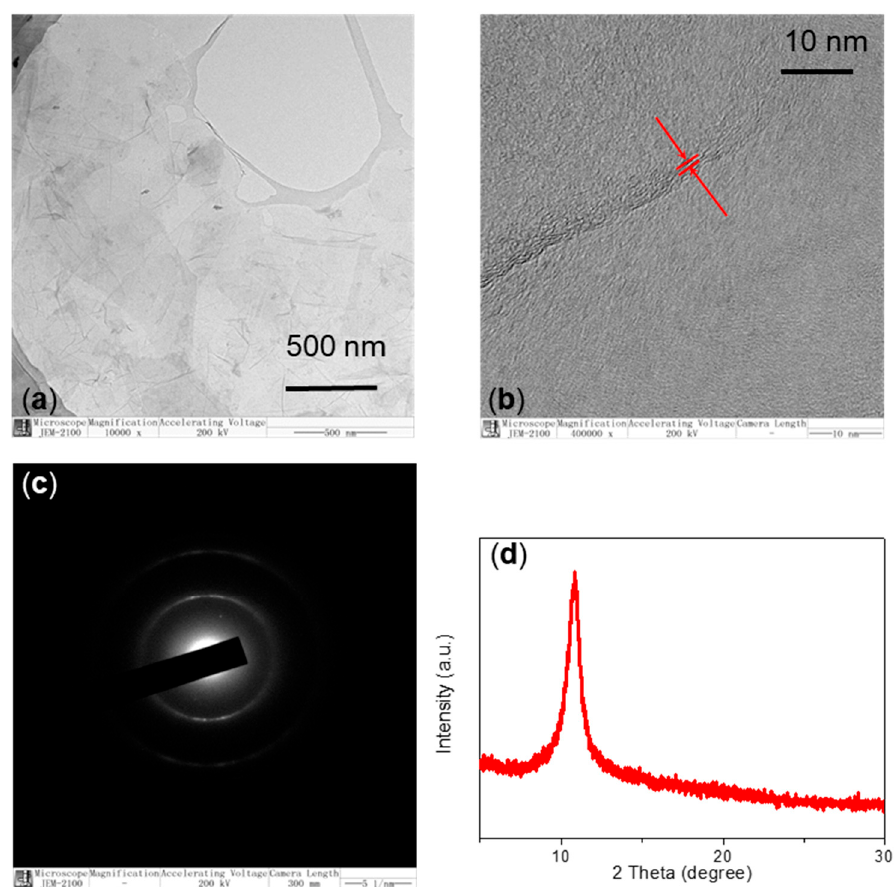
Figure 5. ( a ) Transmission electron microscope (TEM) image of GO powder and ( b ) its high-resolution TEM image; ( c ) selected area electron di ff raction (SAED) pattern and TEM micrograph in magnification of 10,000 × of GO. ( d ) XRD pattern of GO.